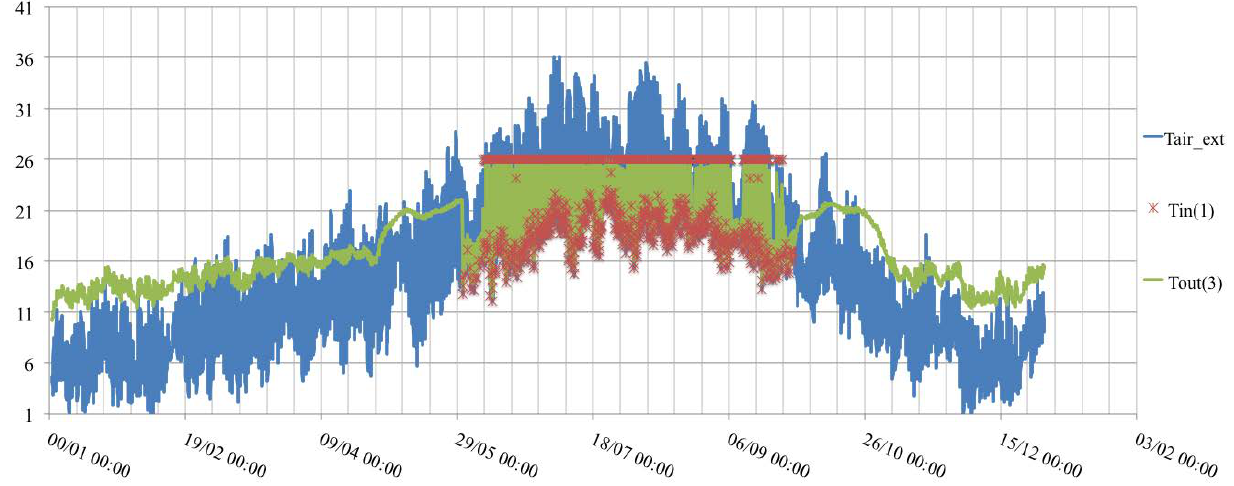
Figure 13. Façade temperatures over a 12-month period.